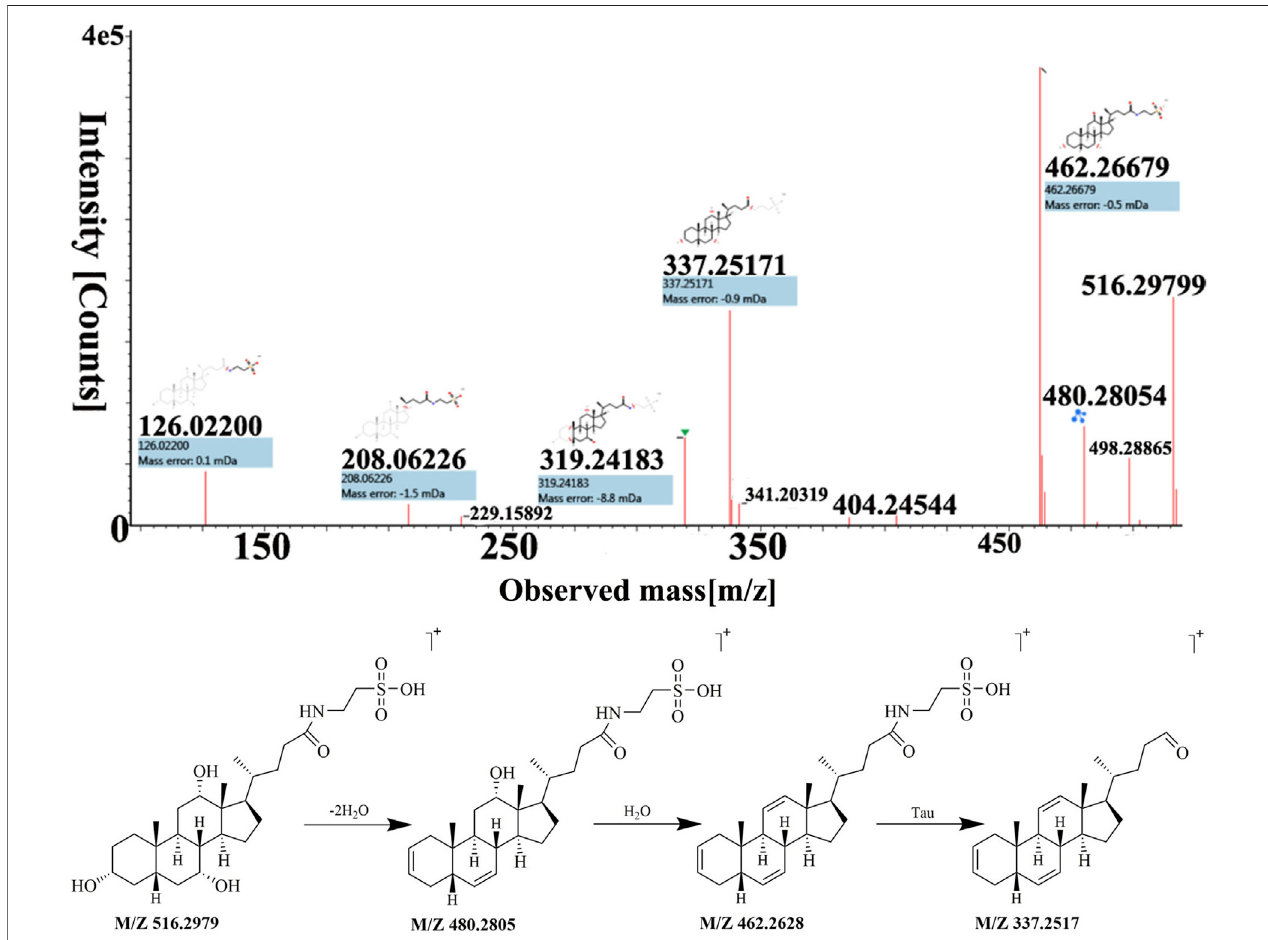
FIGURE 4 | The MS spectra and fragmentation pattern of taurocholic acid in positive ion